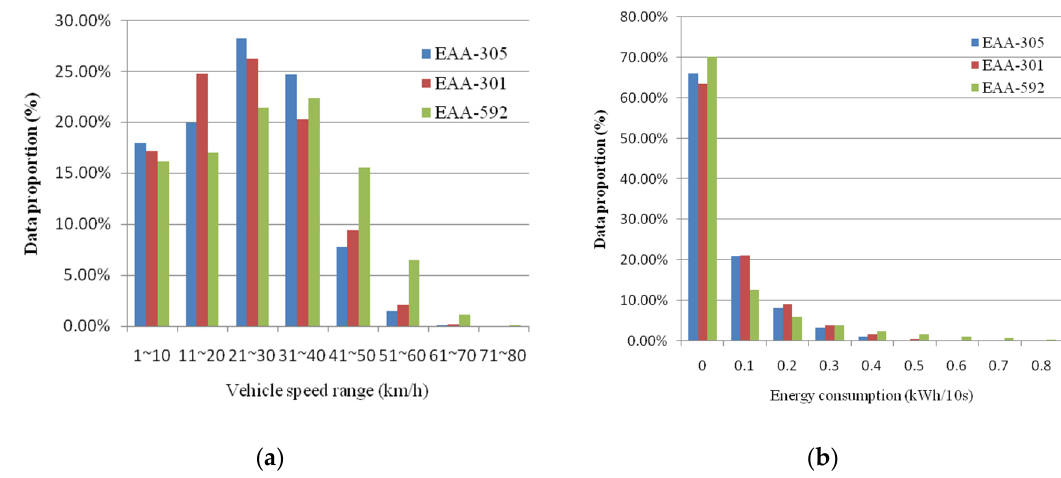
Figure 10. ( a ) Vehicle speed distribution of each scheme in the case study; ( b ) Power consumption distribution of each scheme in the case study. Table 10. Classification indicators of each model in the case study.